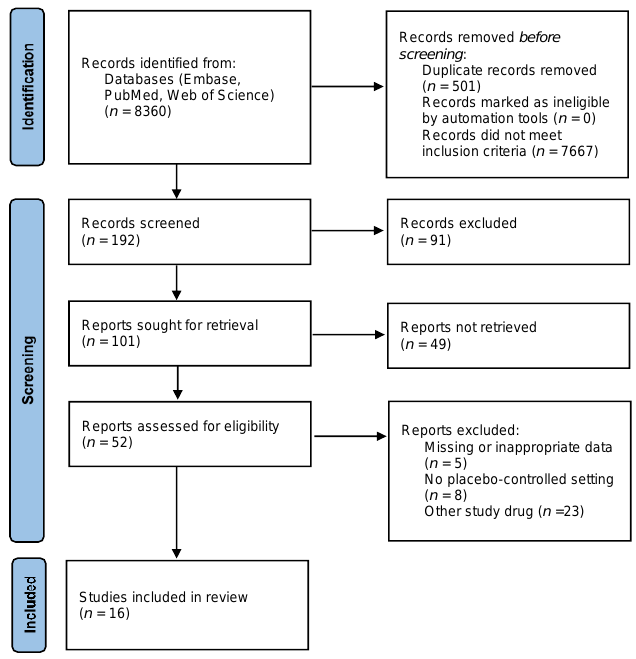
Figure 1. PRISMA flow diagram. Table 1. Summary of nabilone studies.